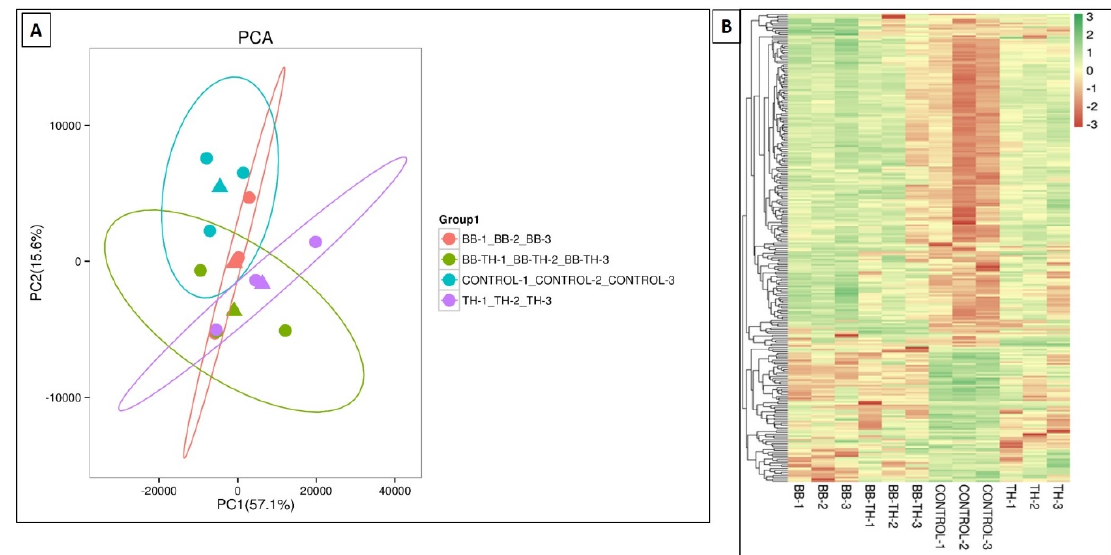
Figure 8. PCA analysis showing variability of data ( A ) and hierarchical cluster analysis showing expression level of DEGs in all treatments ( B ). Green color indicates genes with a higher expression and red color indicates lower expression.